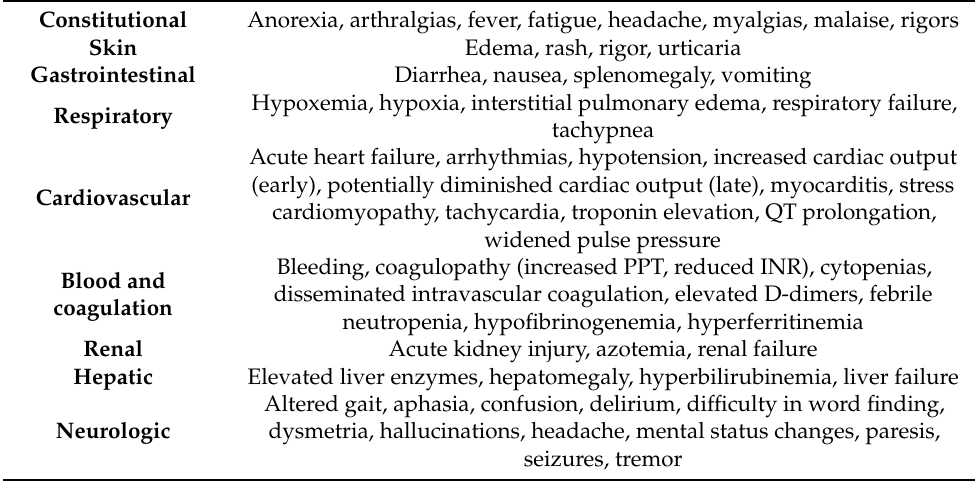
Table 3. Clinical signs, symptoms and laboratory findings associated with cytokine